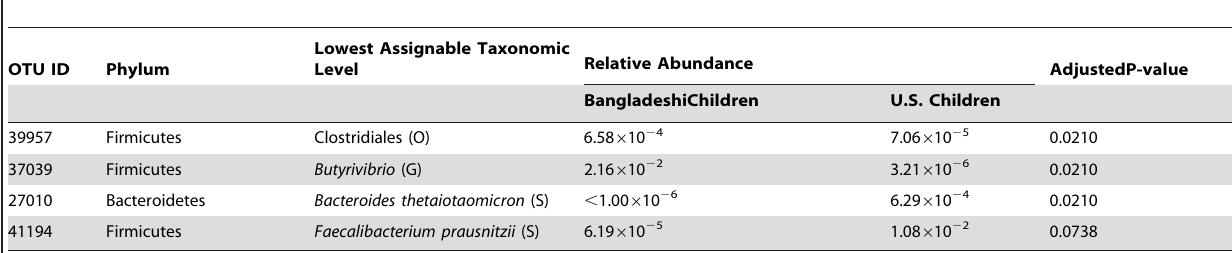
Table 3. OTUs whose relative abundance differed significantly between U.S. and Bangladeshi